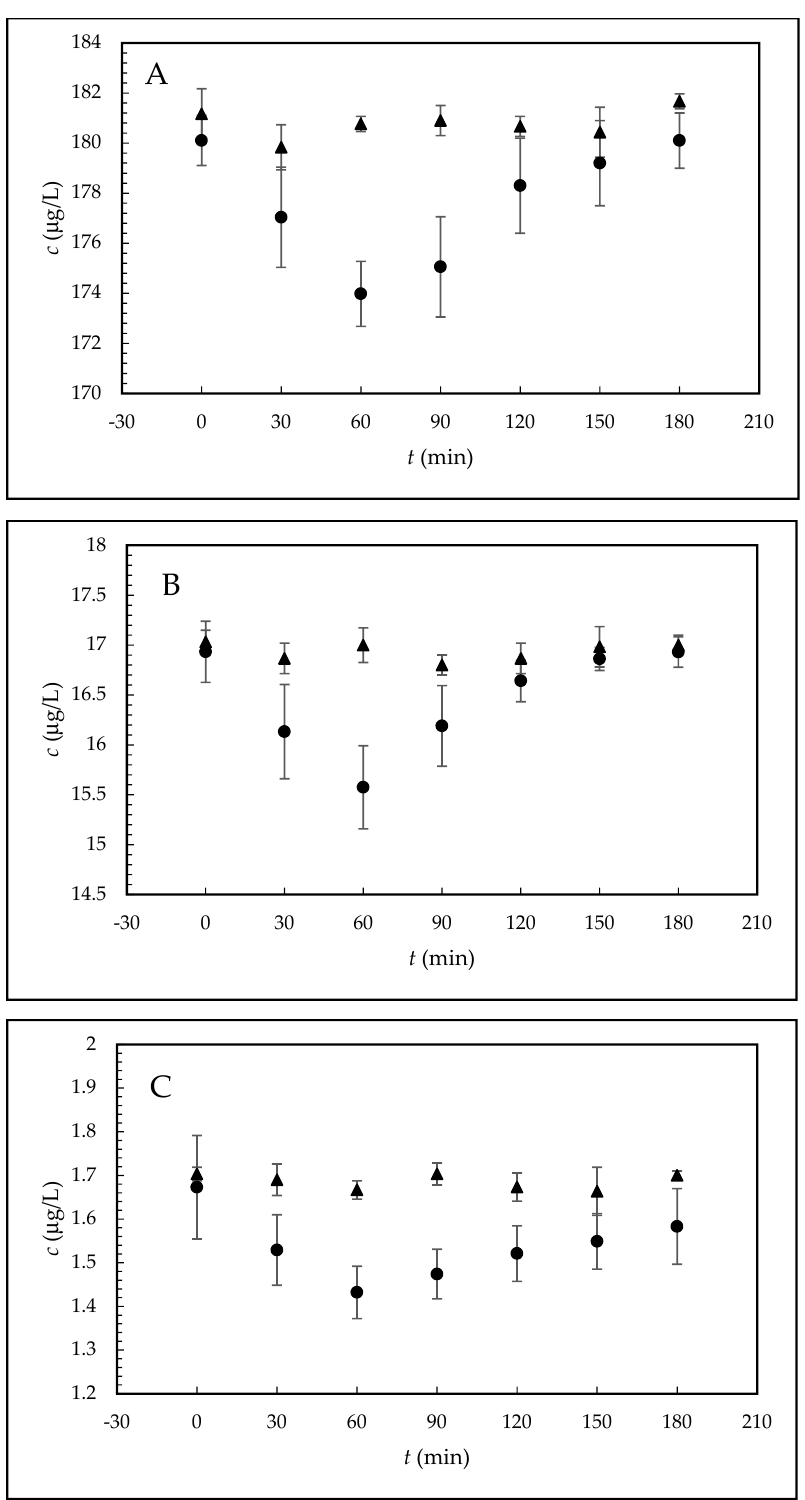
Figure 1. Dependencies of the concentration of the overall unbound 17 α -ethynylestradiol (EE2) on the time of mouse sperm capacitation in vitro. The tested concentrations of EE2 in the capacitating medium were ( A ) 200 µ g / L, ( B ) 20 µ g / L, and ( C ) 2 µ g / L. The samples were prepared in three parallel sets, where each set represented sperm collected from one individual (dots). The blanks were prepared and measured in parallel (triangles). Experimental conditions: 50 / 50 ( v / v ) acetronitrile (ACN) / H 2 O, both containing 0.1% formic acid (HCOOH), measured in the multiple reaction monitoring (MRM) mode for transition 279.1 → 133.0; the error bars were calculated using the standard deviations ( n ’ =